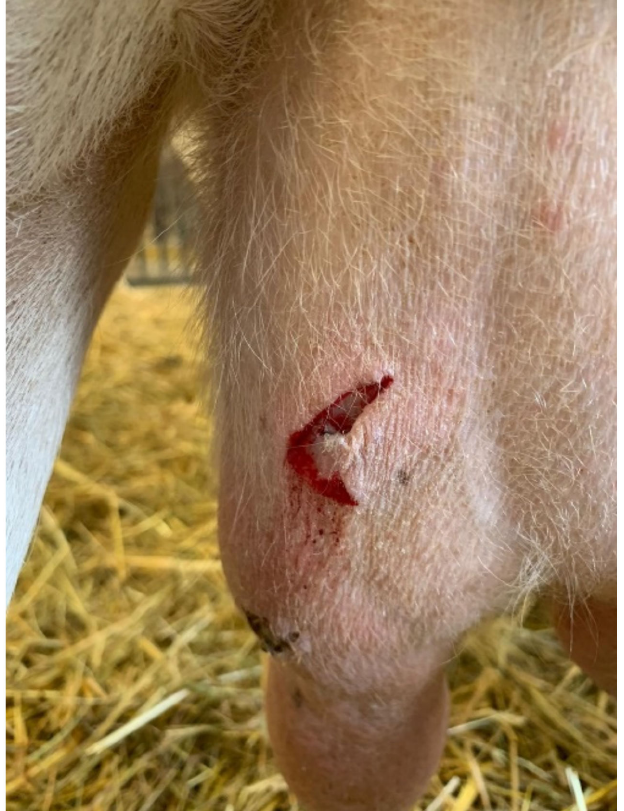
Figure 2. Fresh (in focus) and older, already crusty injury (at the base of the teat) on the left udder of a Saanen goat. The injuries were caused by horn blows from horned flock